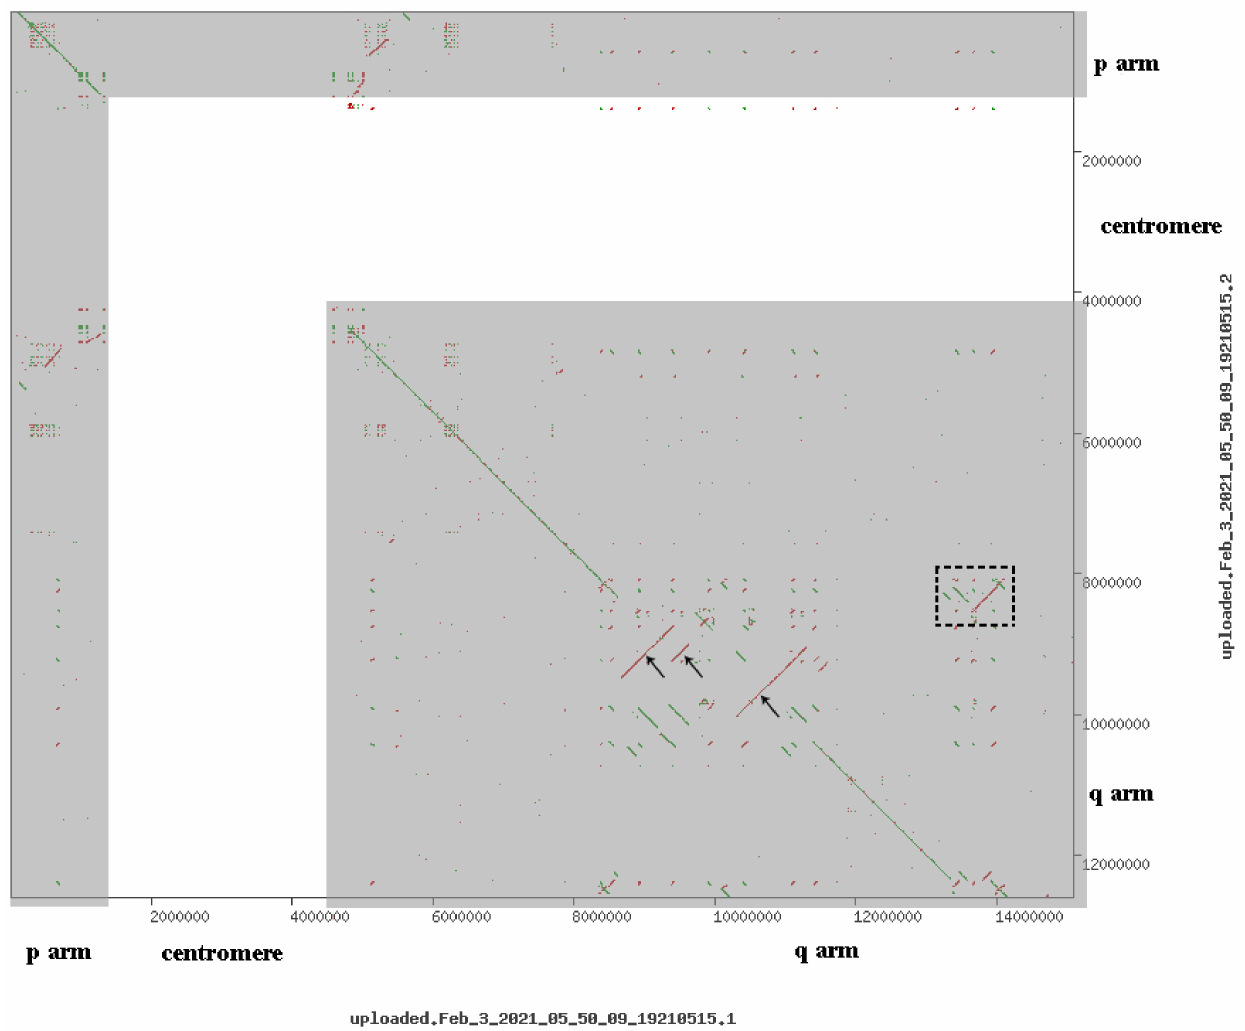
Figure 11. Comparative dot-plot analysis of the region of the sSMC in different human genome assemblies: hg19 (x-axis) and hg38 (y-axis). Dots indicate homologous regions. Transposable elements (SINEs, LINEs, etc.) are hard-masked with N. Dotted square to the right highlighted the area, which in the assembly hg38 is included in the additional chromosomes, but hg19 is not included in the assembly. Arrows indicate areas inversions in assemblies hg19 and hg38. p arm, centromere, q arm denote areas of the short, centromere and long arm of chromosome 10 corresponding line of coincidence of two assemblies located along diagonals. White area is a centromere region of chromosome 10, whereas grey areas denote p arm and q arm of chromosome